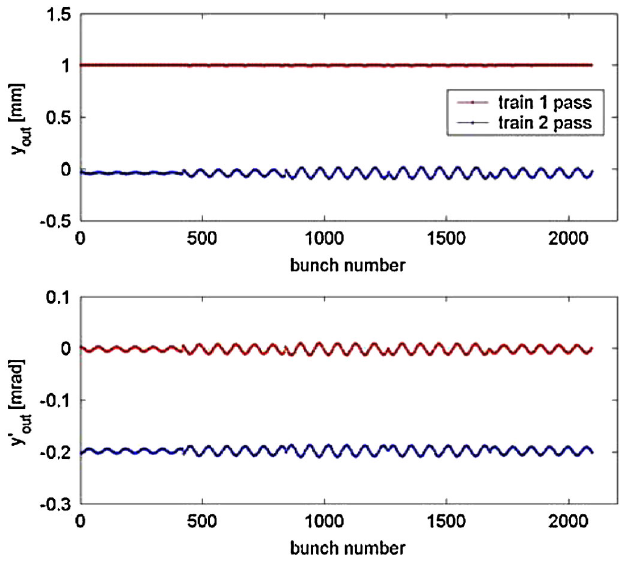
FIG. 20. (Color) Vertical beam positions and angles of the bunch centroids for a beam passing 1 mm vertically off axis inside the